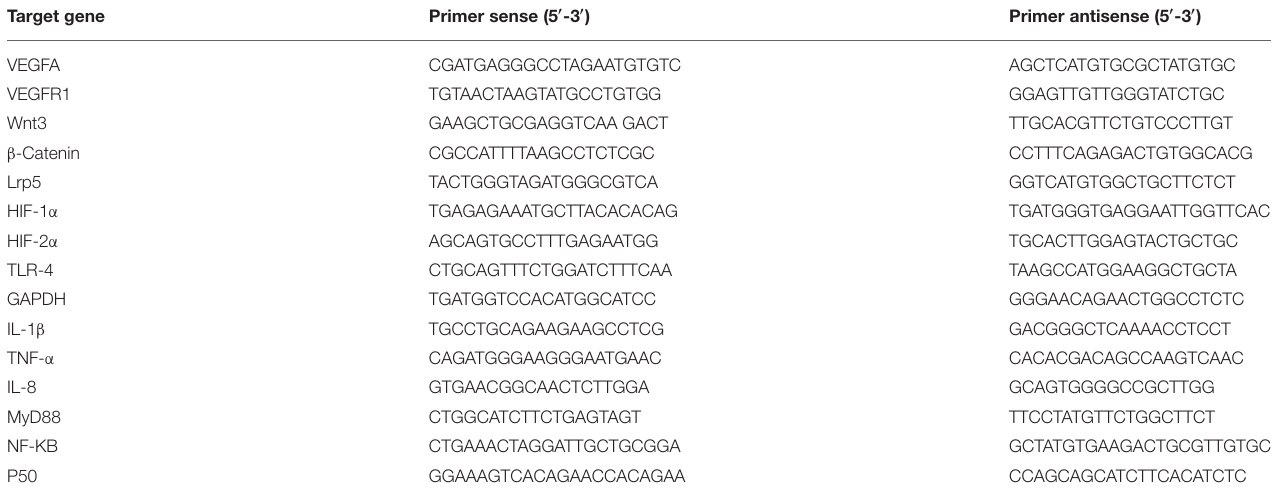
TABLE 1 | Primers for real-time PCR. Target